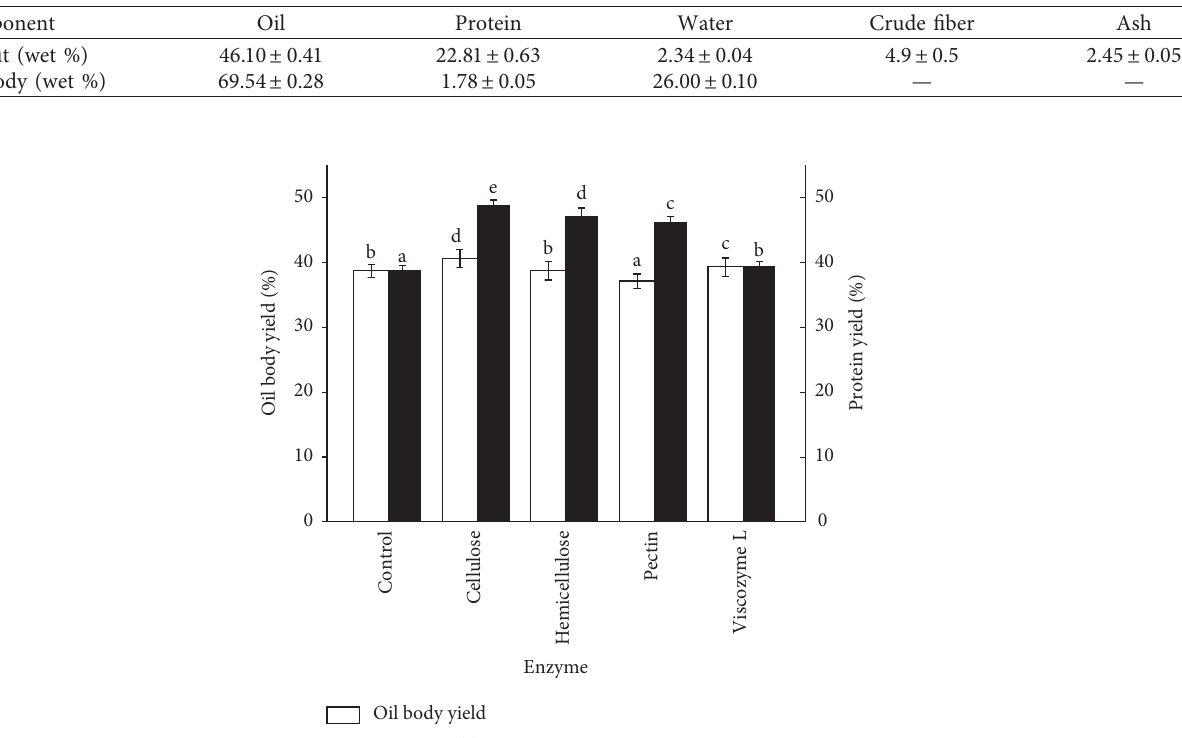
Table 1: Main components of peanut and oil body.